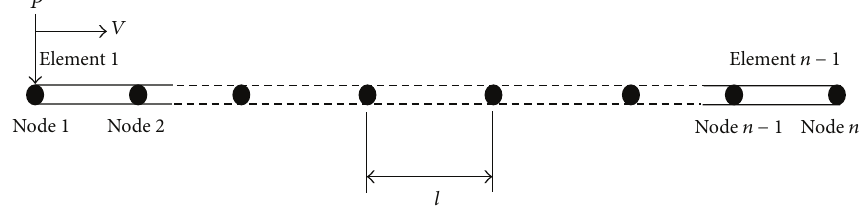
Figure 7: A beam subjected to a concentrated force, 𝑃 , moving with velocity, 𝑉 .